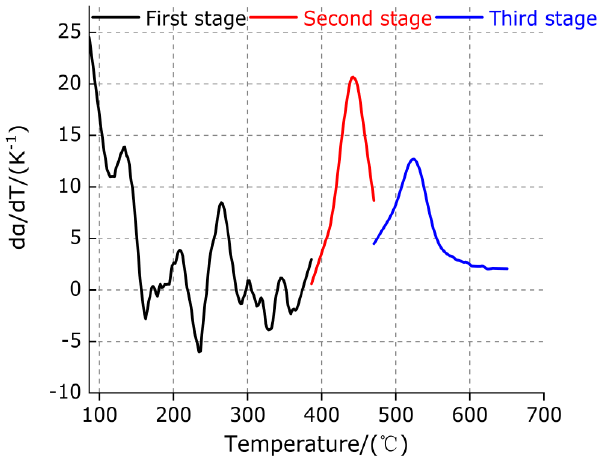
Figure 10. DTG curve of TiH 2 in each stage.